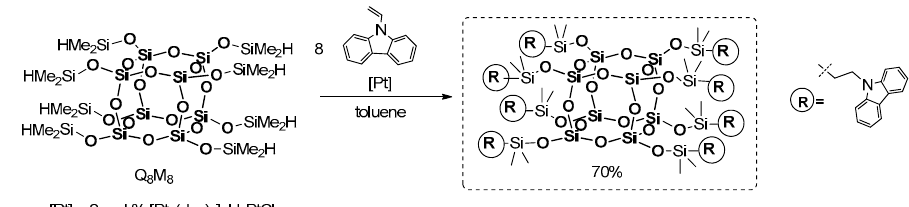
Figure 22. Hydrosilylation reaction towards efficient synthesis of octakis [2-carbazol-9-yl]- ethyldimethylsiloxy]silsesquioxane.